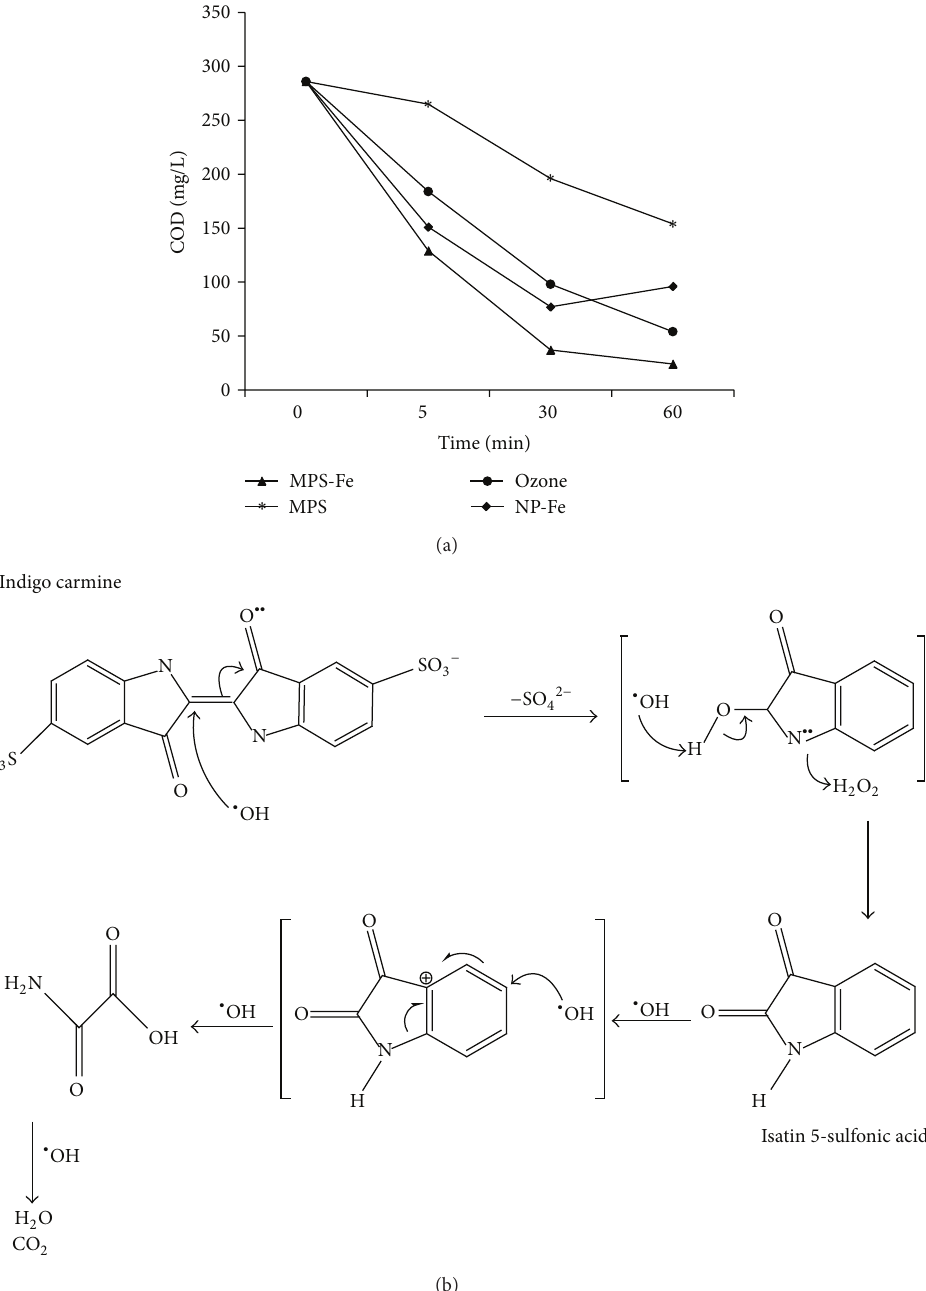
Figure 7: (a) Effect of catalyst type on chemical oxygen demand (COD); (b) proposed indigo carmine degradation mechanism.